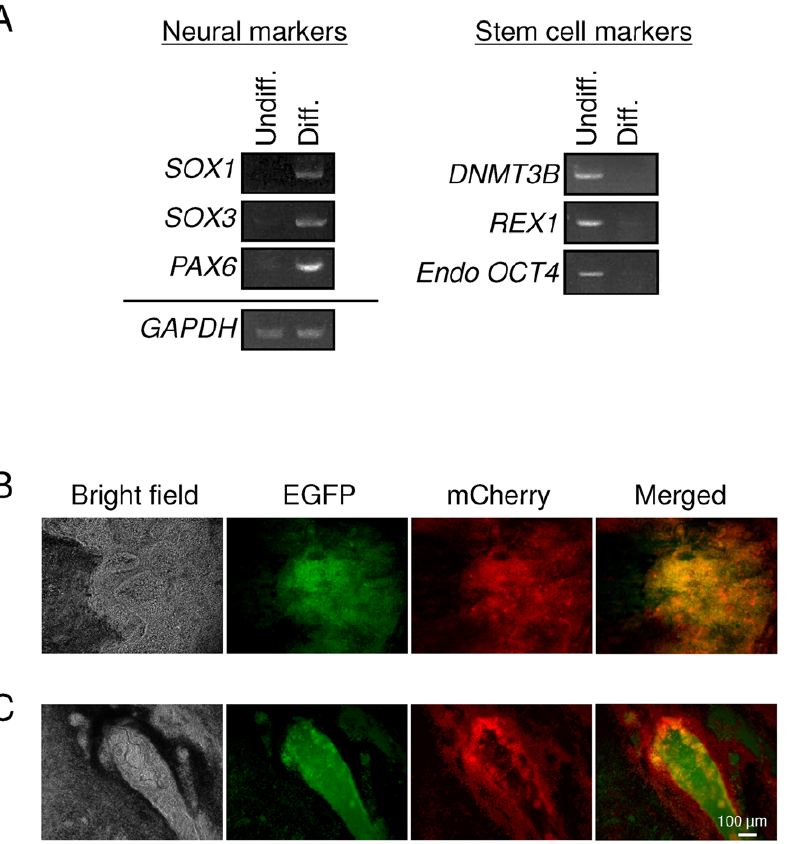
Figure 7. hiPSCs transduced with the reporter vector containing miRNA targets indicate differentiation-specific reporter expression in neural lineages. EBs generated from pooled hiPSCs were differentiated into neural lineages using Noggin and SB431542. EBs were then transferred onto fibronectin coated 6-well plates and further differentiated in N2 medium. (A) Total RNA was isolated using QIAGEN’s RNeasy Mini kit from the hiPSCs on day 0 (undifferentiated population: Undiff.) and day 30 (differentiated population: Diff.) after induction of differentiation. Total RNA (250 ng) was reverse-transcribed using QIAGEN’s Omniscript reverse transcription kit and used as a template in subsequent PCR with 5- PRIME’s HotMaster Taq DNA polymerase. PCR products were analyzed on a 2% agarose gel. GAPDH was used as an internal control. (B) Neural tube- like rosettes observed after the differentiation. (C) Dark pigmented melanocyte-like cells surrounding neural tube-like structures.